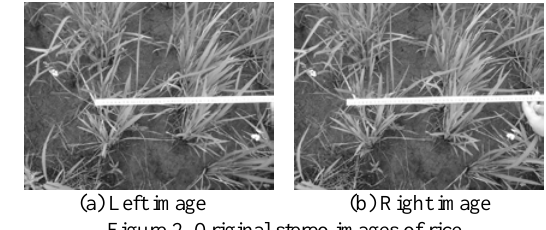
Figure 2. Original stereo images of rice